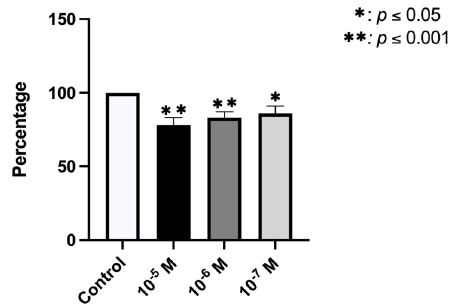
Figure 5. Phagocyte capacity of osteoblasts cell lines after treatment with BPA at different doses of 10 −5 , 10 −6 , or 10 −7 M determined by means of flow cytometry. The data are expressed as the mean of the percentage of cells positive for phagocytosis with respect to control group ± standard deviation. Significant differences * p < 0.05; ** p < 0.001.